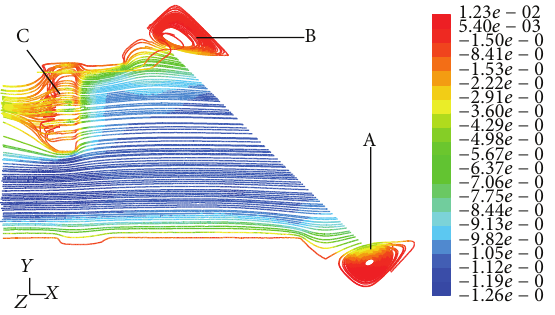
Figure 4: The diagram of sound channel ( 𝑅 𝑒 = 145 ).